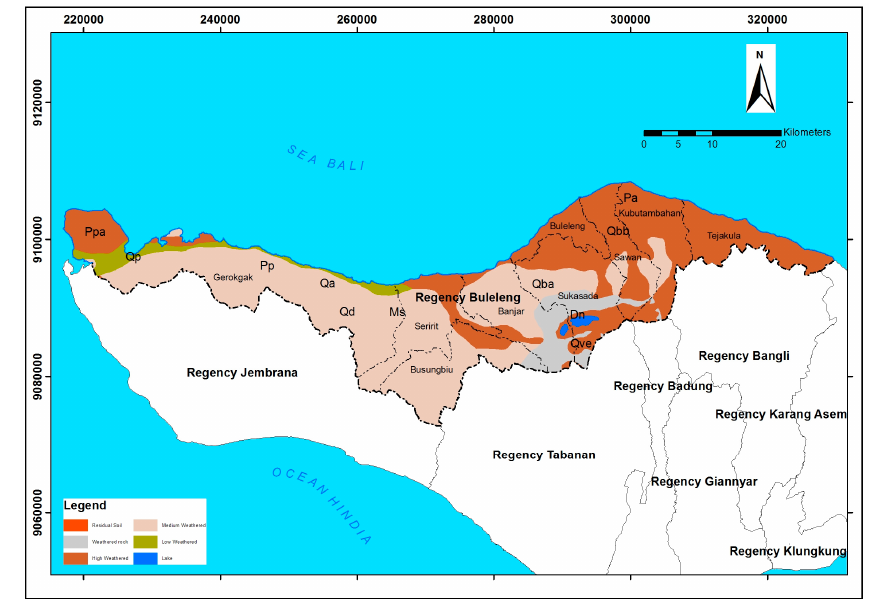
Figure 6. Rock weathering on the study area.